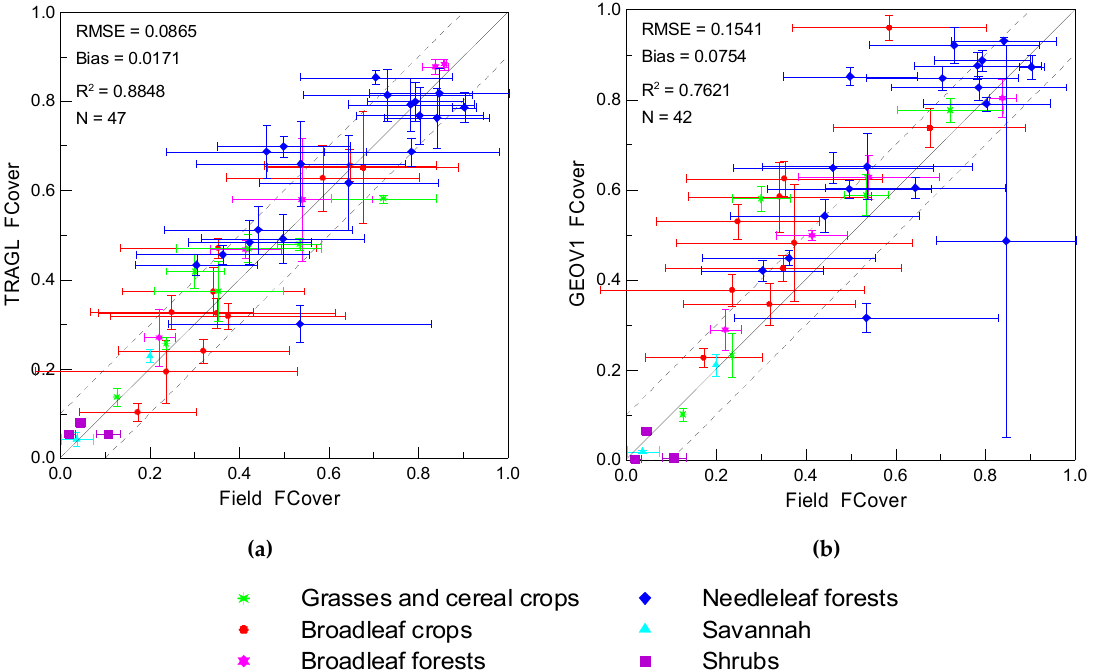
Figure 7. Scatterplots of ( a ) TRAGL and ( b ) GEOV1 FCover products versus mean values of the high resolution FCover maps. The R-squared, RMSE, and bias values are also shown. N is the number of matched data pairs for each case.